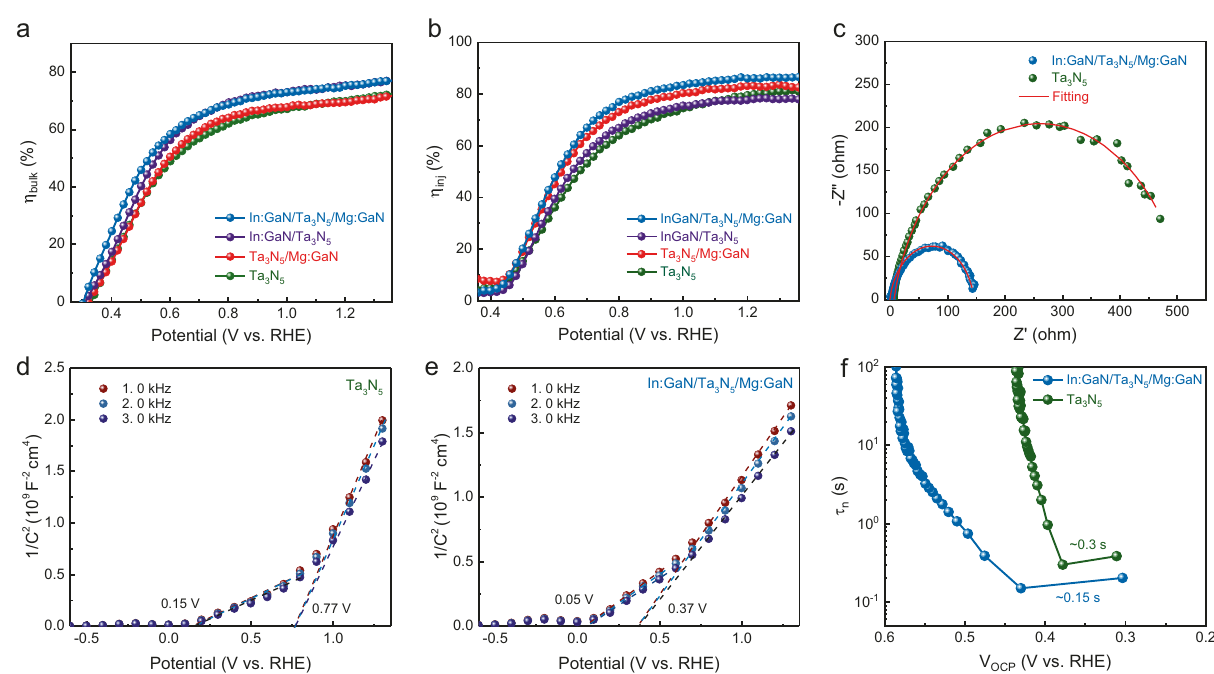
Fig. 5 Electrochemical characterizations of the Ta 3 N 5 -based thin fi lms with different layered structures on Nb substrate. a Bulk charge separation ef fi ciency ( η bulk ). b Surface injection ef fi ciency ( η inj ). c PEIS of Ta 3 N 5 and In:GaN/Ta 3 N 5 /Mg:GaN photoanodes measured in 1 M KOH electrolyte at 1.0 V vs. RHE under AM 1.5 G illumination. Red lines show the fi tting of the PEIS data. M-S plots of d , Ta 3 N 5 photoanode, and e In:GaN/Ta 3 N 5 /Mg:GaN photoanode. The M-S plots were measured in the dark without co-catalyst. f Carrier lifetimes derived from OCP-decay curves at the light on-off transient for Ta 3 N 5 and In:GaN/Ta 3 N 5 /Mg:GaN